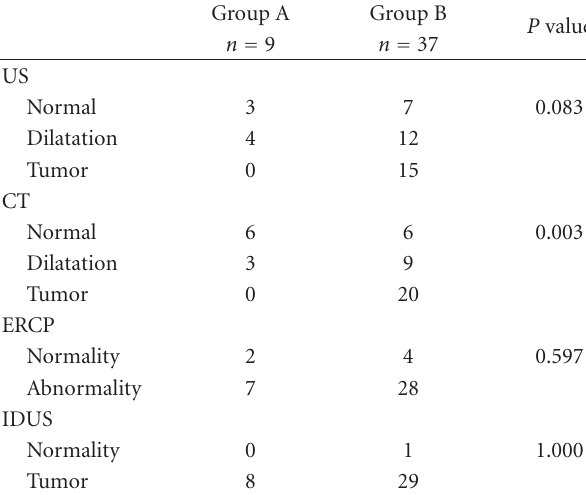
Table 3: Radiologic findings.